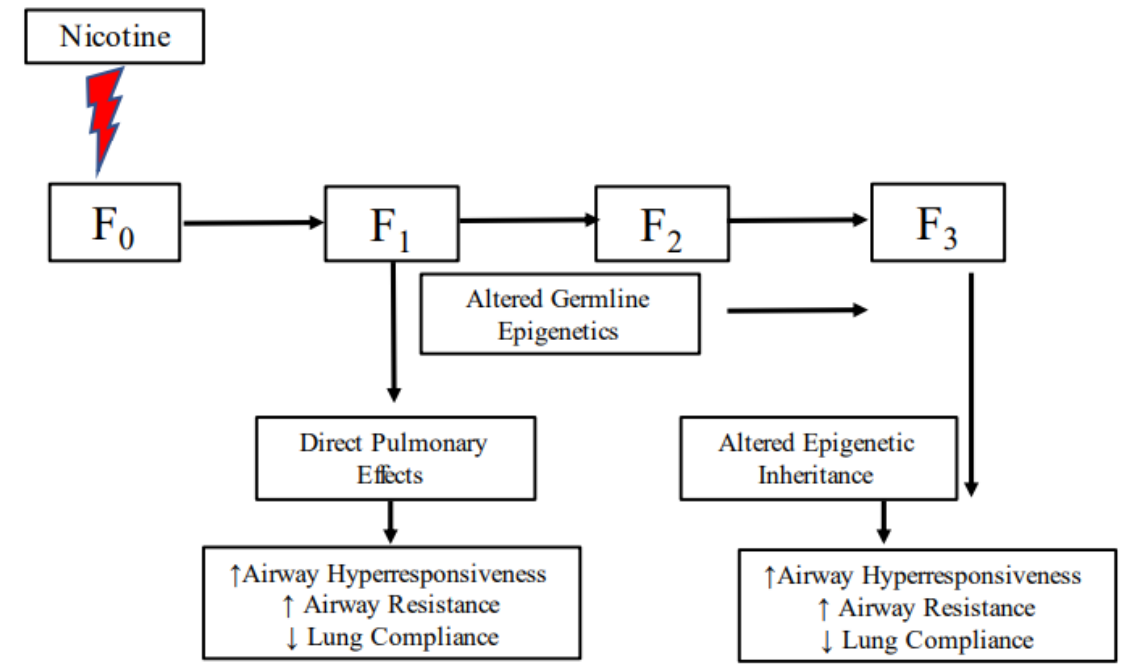
Figure 2. Schematic representation of perinatal nicotine exposure-induced transgenerational trans- mission of asthma via altered epigenetic inheritance.